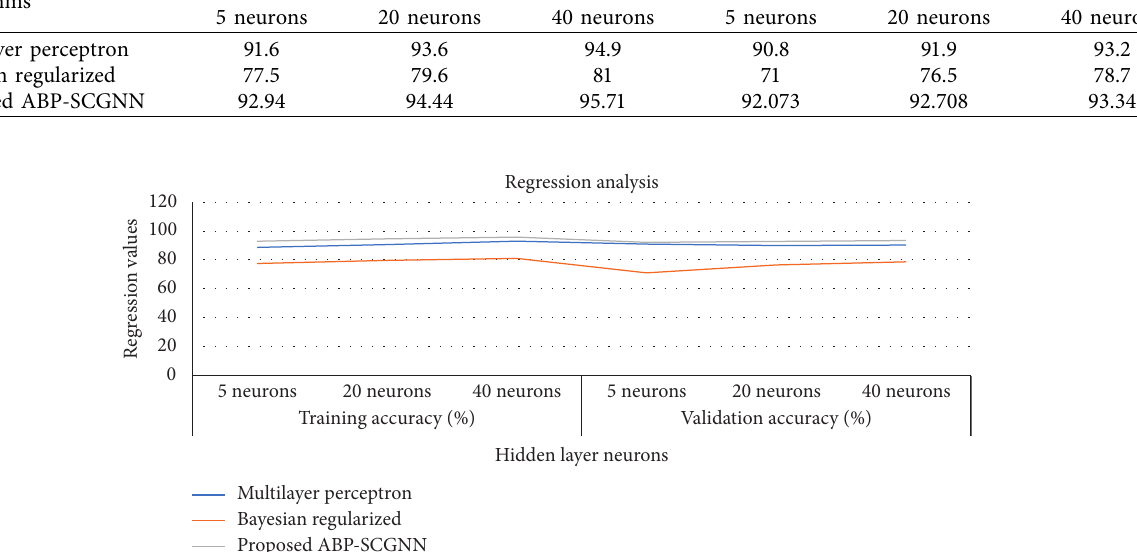
Table 2: The performance analysis of the ABP-SCGNN model compared with standard ANNs models using an accuracy measure. Algorithms